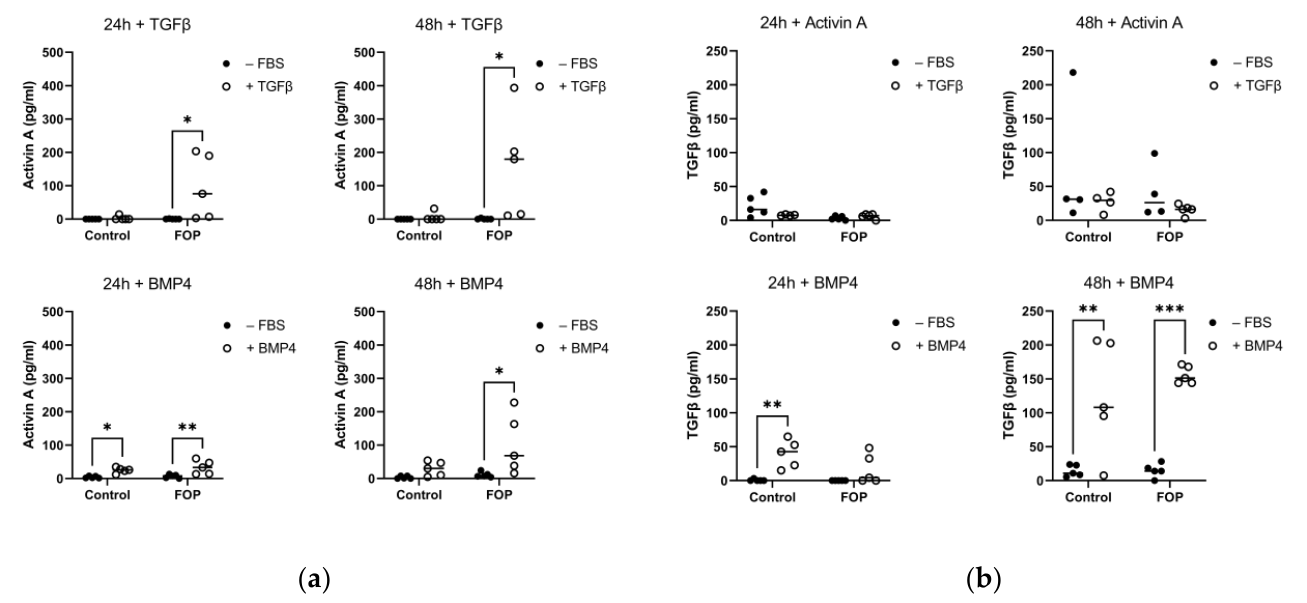
Figure 3. Activin A and TGF β 1 production measured by ELISA upon Activin A, TGF β 1, and BMP4 stimulation in FOP and control fibroblasts. Fibroblasts were subjected to overnight serum starvation ( − FBS) before being stimulated with TGF β 1 and BMP4 for 24 and 48 h. This was followed by the measurement of ( a ) Activin A and ( b ) TGF β 1. Data is shown as the production level per cell line and their mean. * p < 0.05, ** p < 0.005, *** p < 0.0005 as determined by 2-way ANOVA.